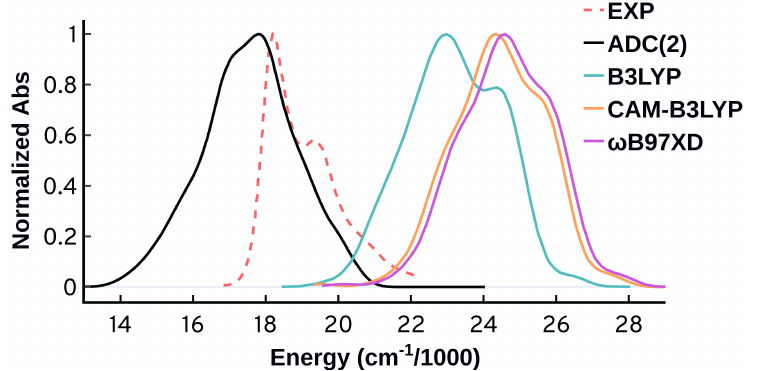
Figure 6. Normalized absorption spectra from an ensemble of 200 geometries generated using Wigner distribution and the harmonic